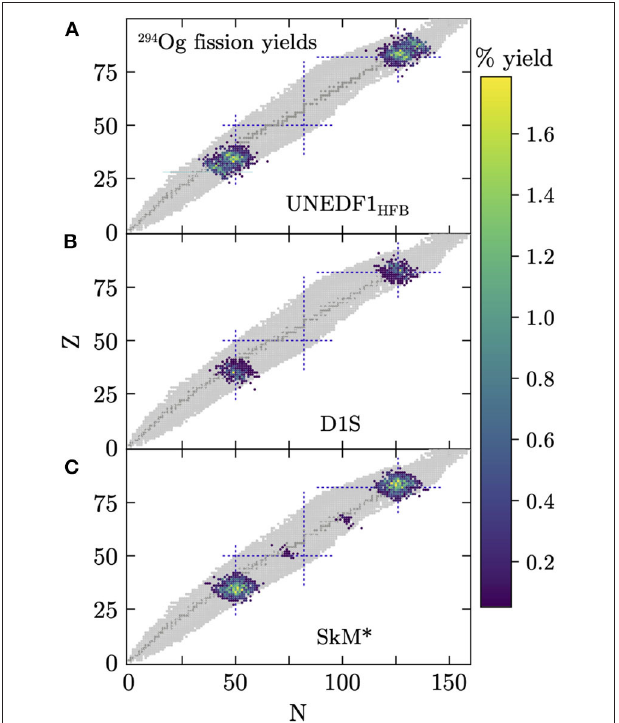
FIGURE 11 | Fission fragment distributions for 294 118 Og 176 obtained in UNEDF1 HFB (A) , D1S (B) , and SkM* (C) EDFs using the non-perturbative cranking ATDHFB inertia and a standard value of dissipation strength [66]. Known isotopes are marked in gray [111]. Dotted lines indicate the magic numbers: 50, 82, and 126. The figure is adapted from Matheson et al. [66].